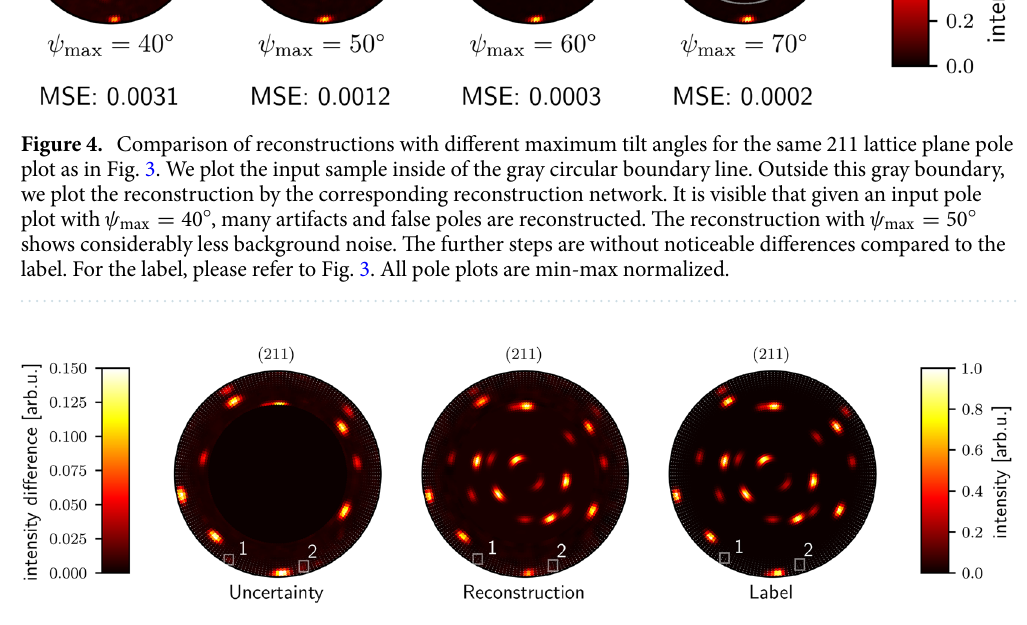
Figure 5. Uncertainty of reconstruction for a 211 lattice plane pole plot with ψ max = 60 ◦ and three visible grains. The left plot shows the standard deviation of outputs of the Monte Carlo dropout network, which we denote with the uncertainty of the model. We used 1000 repetitions of the same input to get sufficient coverage of the output distribution of the dropout network. The input is similar to Fig. 3. The left colormap describes the uncertainty. The right colormap describes the reconstruction and label. All pole plots are min-max normalized, except for the uncertainty plot, which is the standard deviation of min-max normalized pole plots. The area labeled with 1 contains a pole visible in the reconstruction but no pole in the label. Thus, a higher value in the uncertainty plot is visible. The rectangle denoted with 2 contains a higher value for uncertainty. However, there is no pole neither on the reconstruction nor on the label. That means that in some reconstructions a false pole is drawn at this